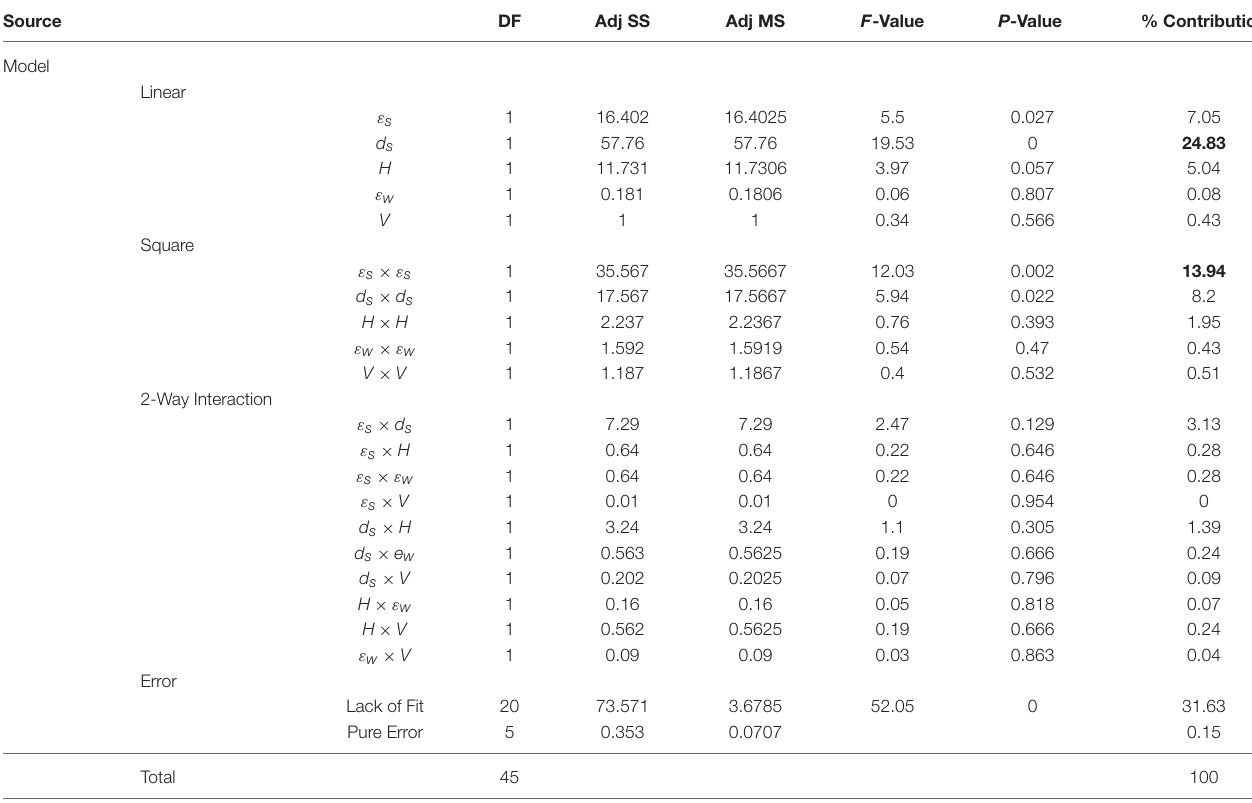
The bold values are the significant result values.